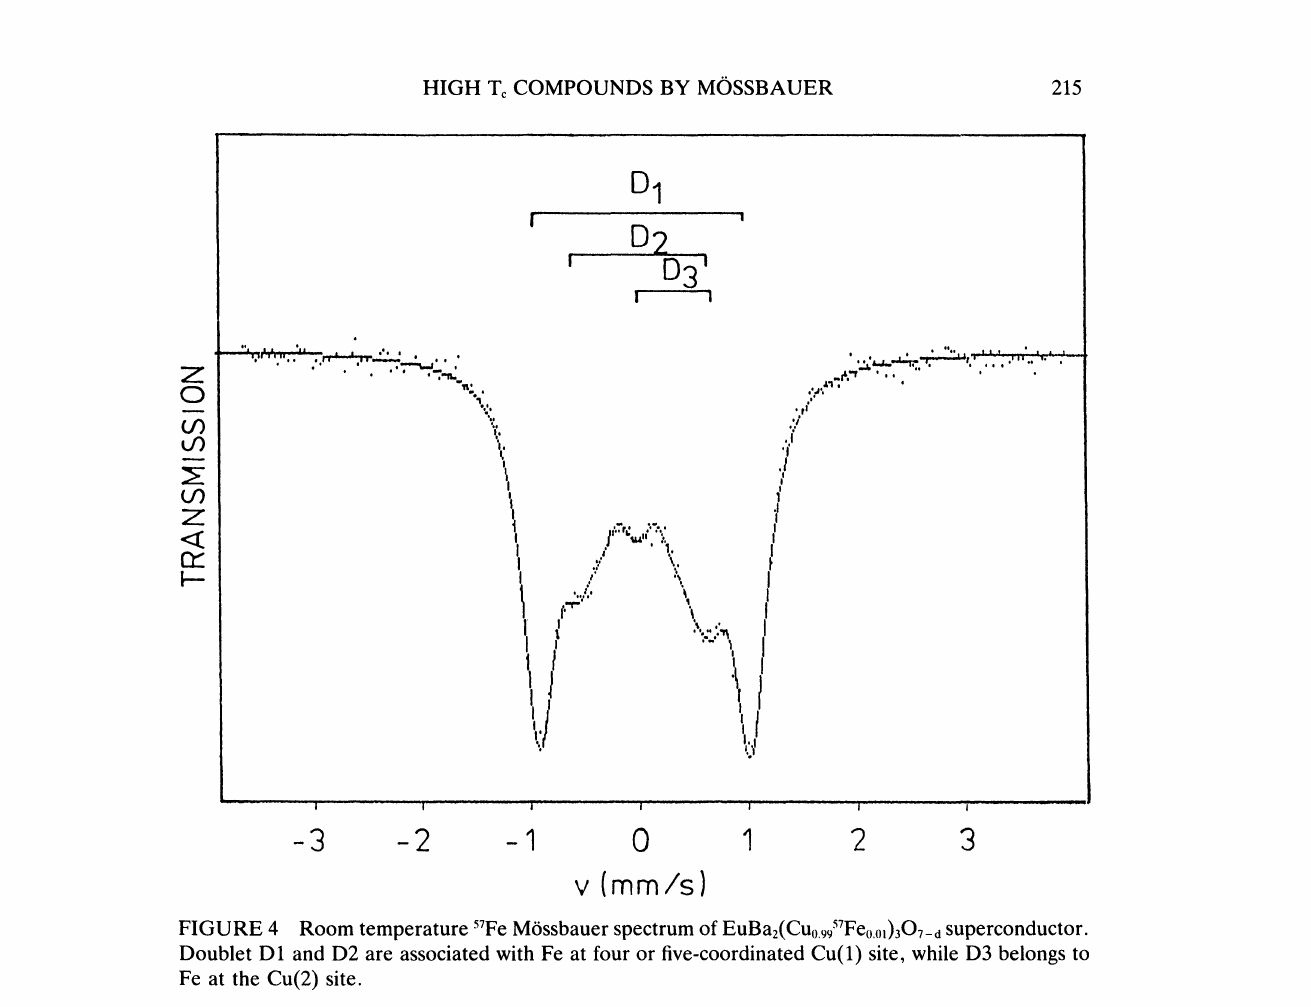
FIGURE 4 Room temperature 57Fe Mssbauer spectrum of EuBa2(Cu0.99TFe0,01)3OT_d superconductor. Doublet D and D2 are associated with Fe at four or five-coordinated Cu(1) site, while D3 belongs to Fe at the Cu(2)